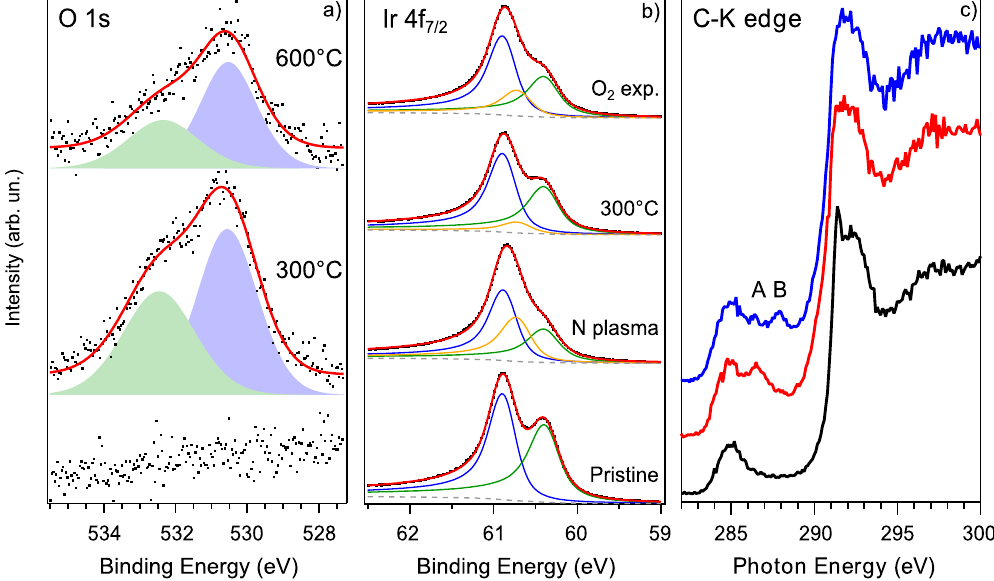
Figure 2. ( a ) O 1 s core level spectra before (bottom) and after the exposure to O 2 for the two samples annealed at 300 and 600 °C after nitrogen plasma; experimental data in black dots, continuous red curve is the fitting result. ( b ) Ir 4 f 7/2 core level spectra. Ir-bulk component is blue, Ir-surface is green and Ir-surface2 is yellow. A Shirley background (grey dashed line) has been used in the fitting. ( c ) From bottom to top: carbon K-edge NEXAFS spectra of pristine graphene/Ir(111) (black), before (red) and after (blue) exposure to O 2 for the sample annealed to 300 °C after nitrogen incorporation. The spectra are recorded with linearly polarized light at normal incidence on the sample and with in-plane